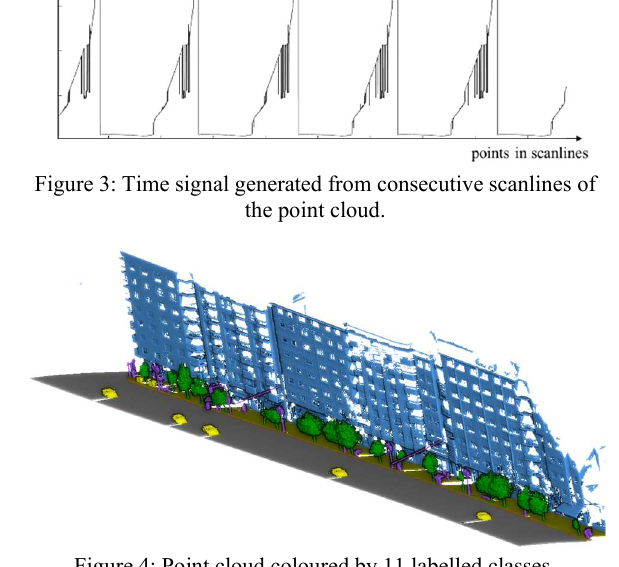
Figure 4: Point cloud coloured by 11 labelled classes.